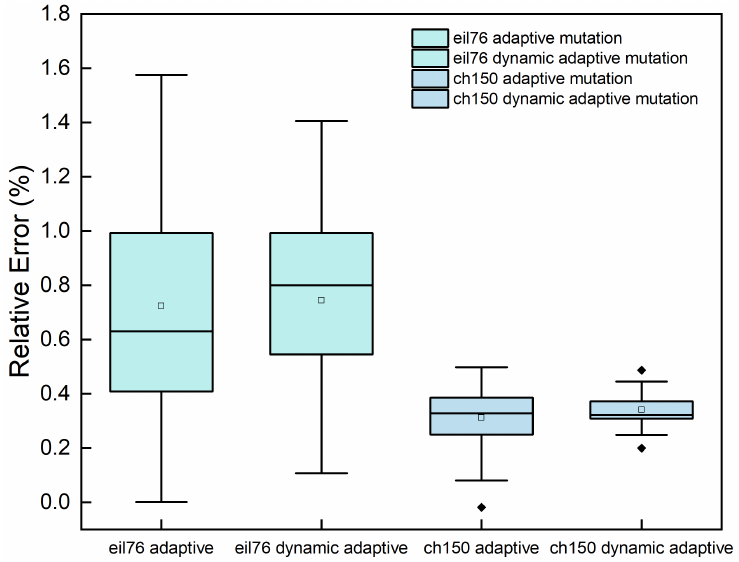
Figure 10. Box plot for the eil76 and ch150 benchmark problems with dynamic adaptive neighborhood mutation and adaptive neighborhood mutation. Table 4. Comparisons with the DJAYA, DTSA, ABC, PSO-ACO, and